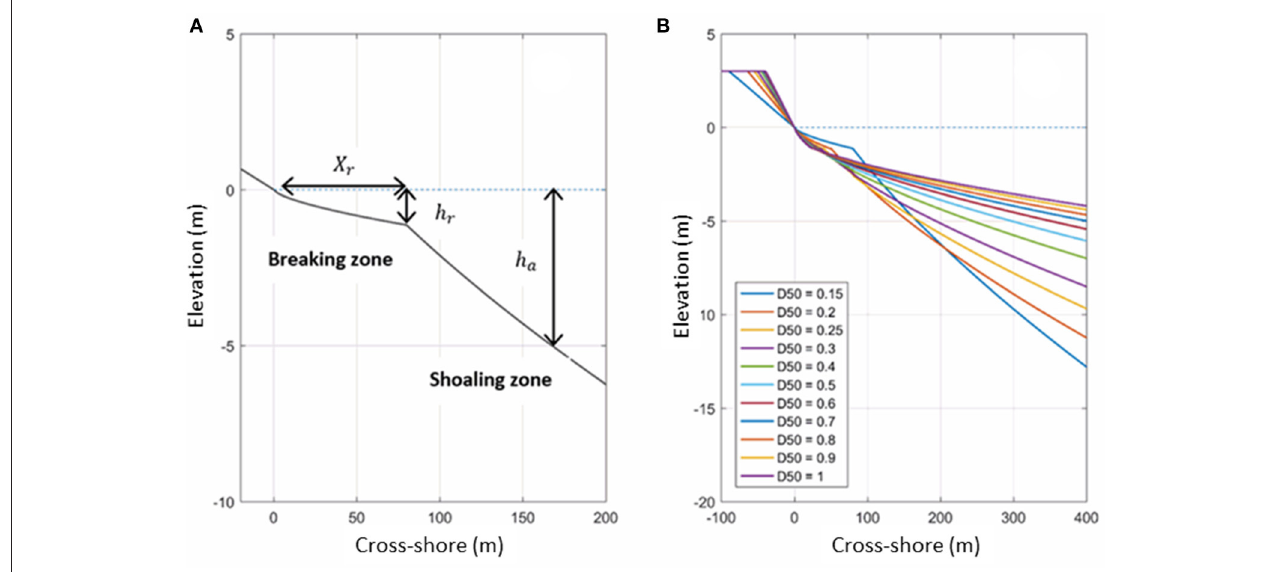
FIGURE 4 | Two-section model profile following the Bernabeu formulation (A) : X r is the horizontal distance between the coastline and the beginning of the breaking zone, h r is the depth that defines the beginning of the breaking zone, and h a is the limit depth of the shoaling zone. The equilibrium profiles considered for different values of the grain size, from D50 = 0.15mm to D50 = 1.0mm (B)